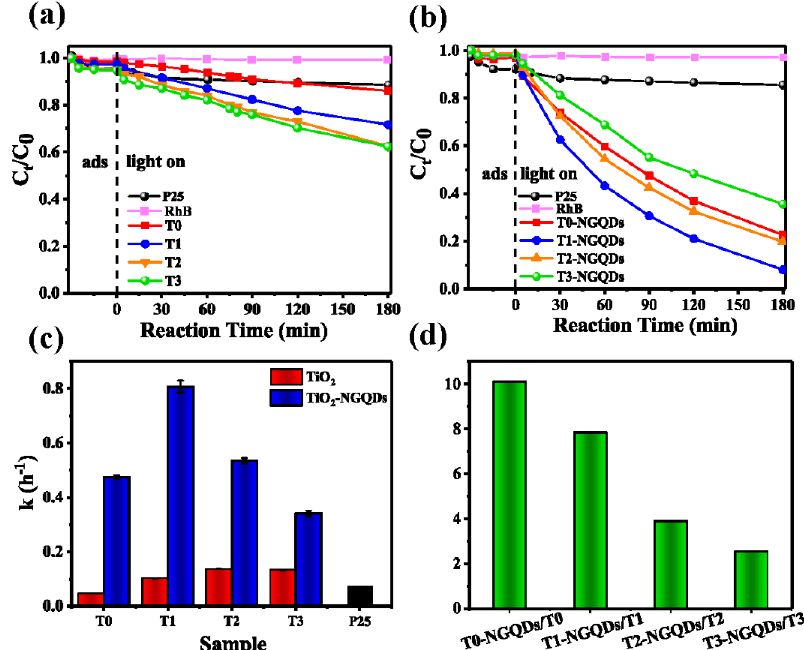
Figure 8. The photocatalytic degradation of RhB for di ff erent samples under visible light irradiation. Change of the relative concentration (C t / C 0 ) of RhB in ( a ) bare anatase TiO 2 , ( b ) TiO 2 / NGQDs composites as a function of irradiation time up to 180 min. ( c ) Plot of k (ln(C 0 / C t )) values for RhB degradation in di ff erent samples. ( d ) The times of the k values of the anatase with and without NGQDs decoration.